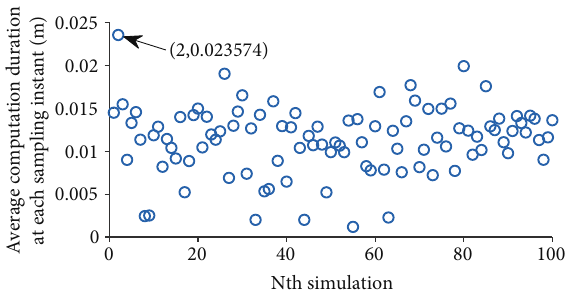
Figure 33: The average computation duration of each simulation.